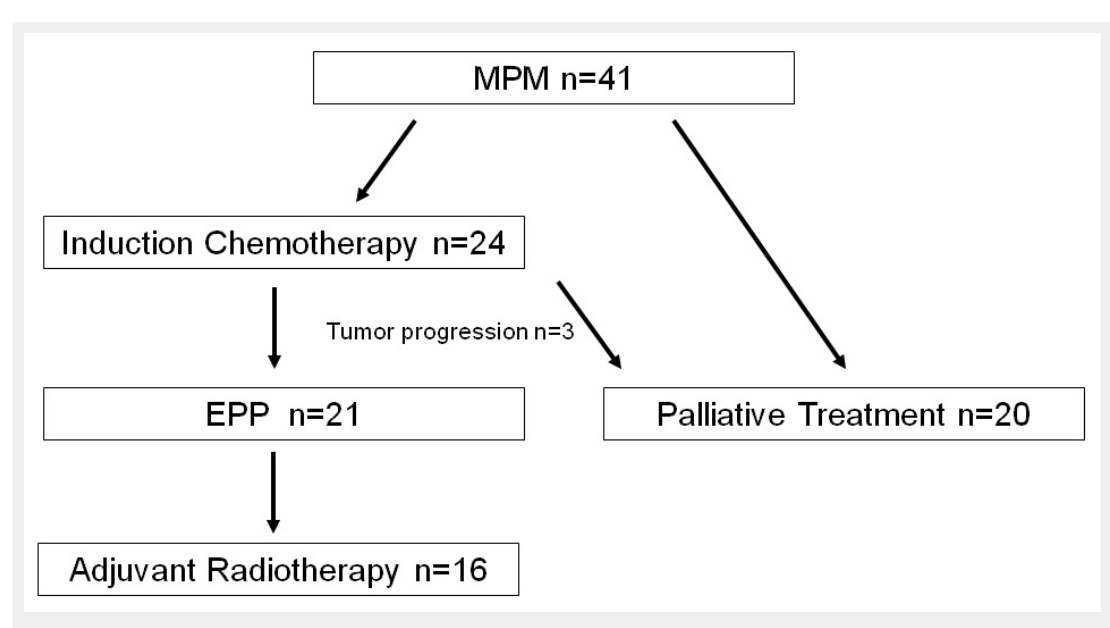
Figure 1 Flow chart showing the patient included in the trimodal or palliative treatment groups.